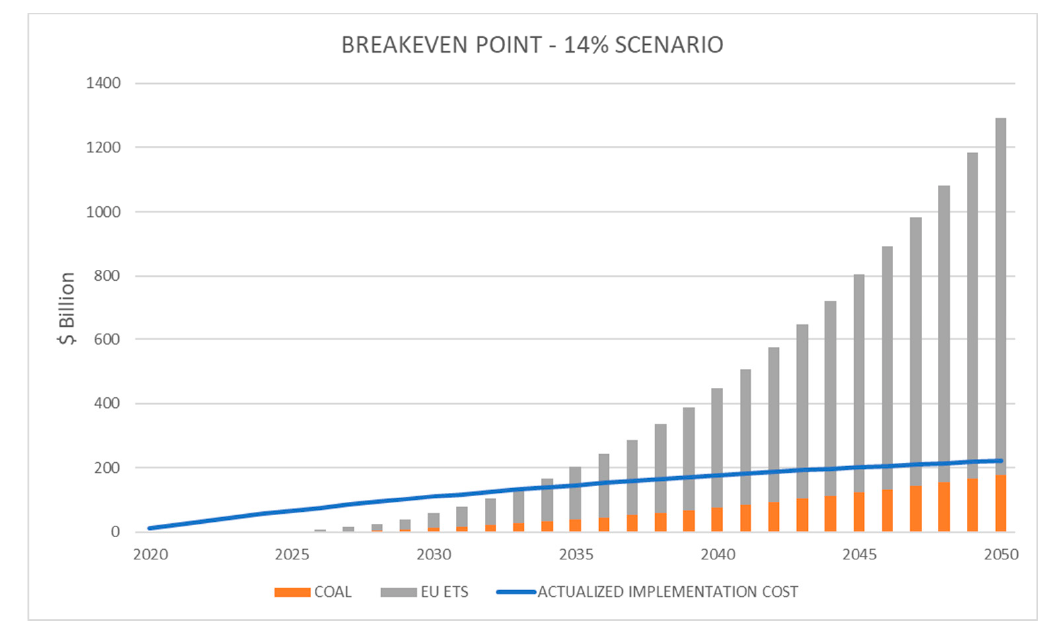
Figure 12. Payback period in the 14% scenario.